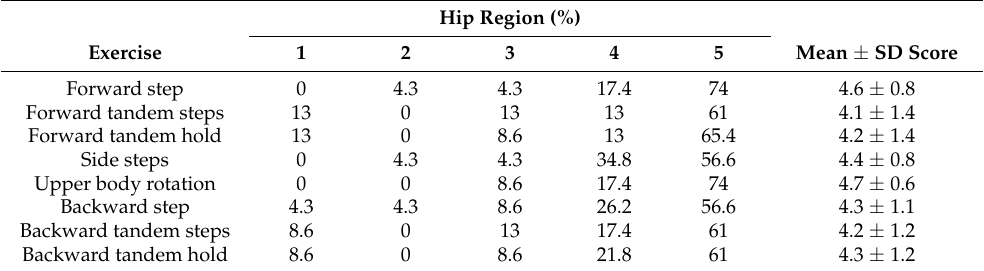
Table 5. Enjoyment scores of the exercises performed at the hip region.